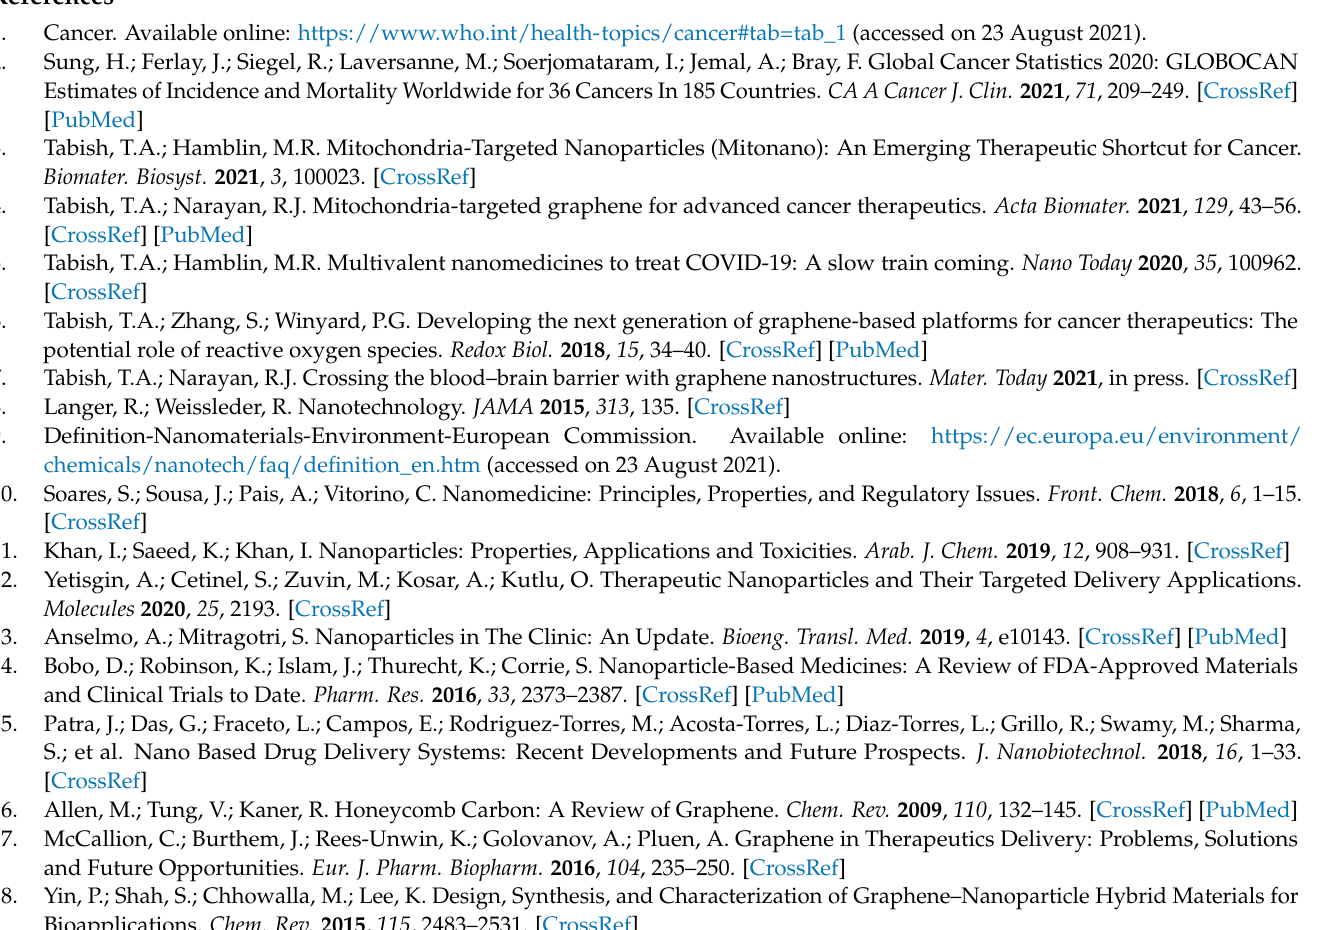
seventeen publications analysed, Table S3: Table displaying the payload characteristics and drug loading information, including both the drug loading capacity and drug loading/encapsulation efficiency, for the seventeen publications, Table S4: A table displaying the experimental conditions under which the drug release was recorded, including the temperature and pH. The maximum cumulative release and the timeframe of the measurement were recorded. Information on the biological assays undertaken by each publication is also recorded, Table S5: This table displays the numerical results of the statistical analysis. The R 2 value, Sy.x value, gradient, and p value are recorded for each of the four kinetic models, for each nanohybrid under the different conditions recorded by the publications. The results are given to 4 decimal